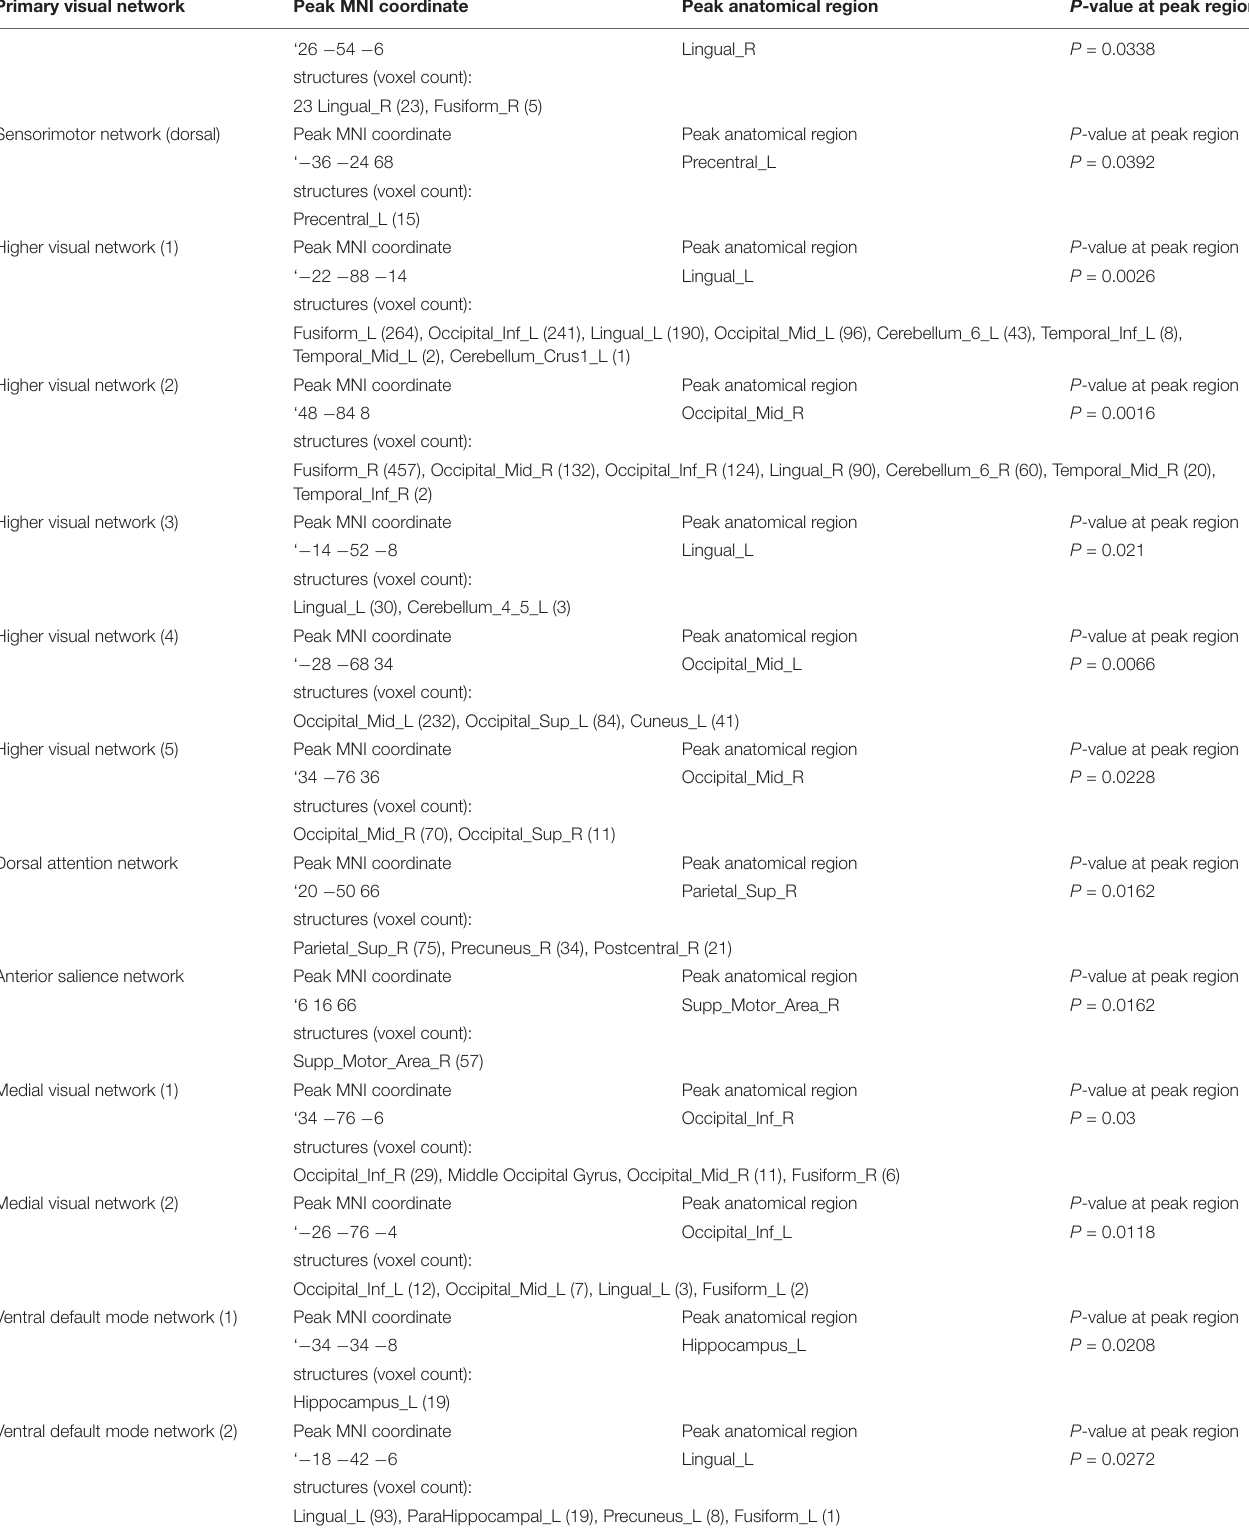
TABLE 6 | Anatomical regions decreasing functional connectivity with age in the canonical RSNs. Primary visual network Peak MNI coordinate Peak anatomical